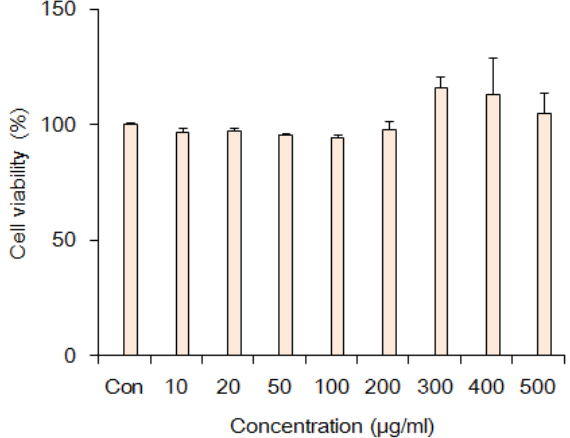
Figure 3. Cytotoxicity of Fermented oyster extracts on cell viability of C2C12 myoblast. Data were shown as mean ± SE (standard error) for groups of three experiments.